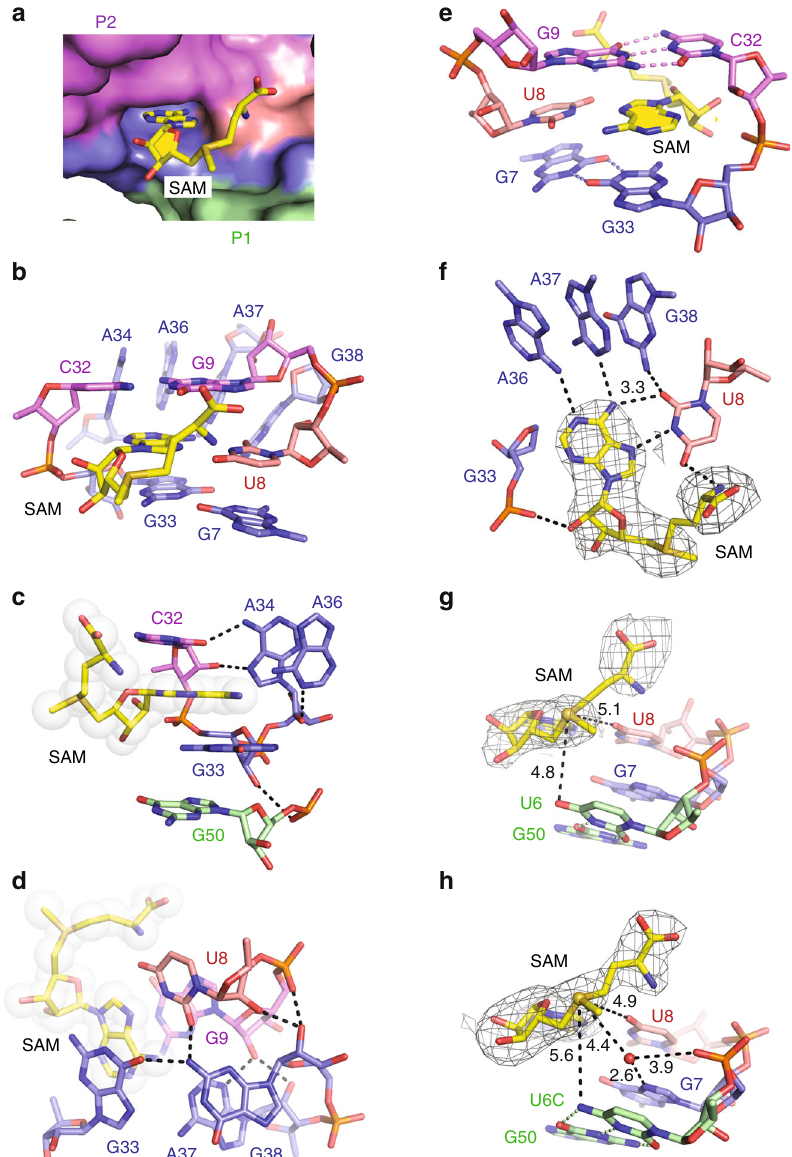
Fig. 2 Structural details of the SAM-VI riboswitch pocket bound to SAM. a RNA surface representation shows the cavity for the adenine base of the SAM ligand buried into the RNA and the methionine moiety directed outwards. b – e Different views on the binding pocket interactions with ligand SAM (for discussion see main text). f Detailed view of the SAM-adenine U8 base pair. The composite omit electron-density map of SAM contoured at the 1.0 σ level is shown in light gray. g Detailed view on the sulfonium moiety and the nearest neighbors (O4 U6 and O4 U8) with selected distances indicated by dotted lines and corresponding values in Å. The composite omit electron-density map of SAM contoured at the 1.0 σ level is shown in light grey. h Binding pocket of the U6C-mutant SAM-VI riboswitch: U6C moves away from the sulfonium moiety; note that a water molecule appears and takes over the role of the mutated U6; distance values are in Å. The composite omit electron-density map of SAM contoured at the 1.0 σ level is shown in light